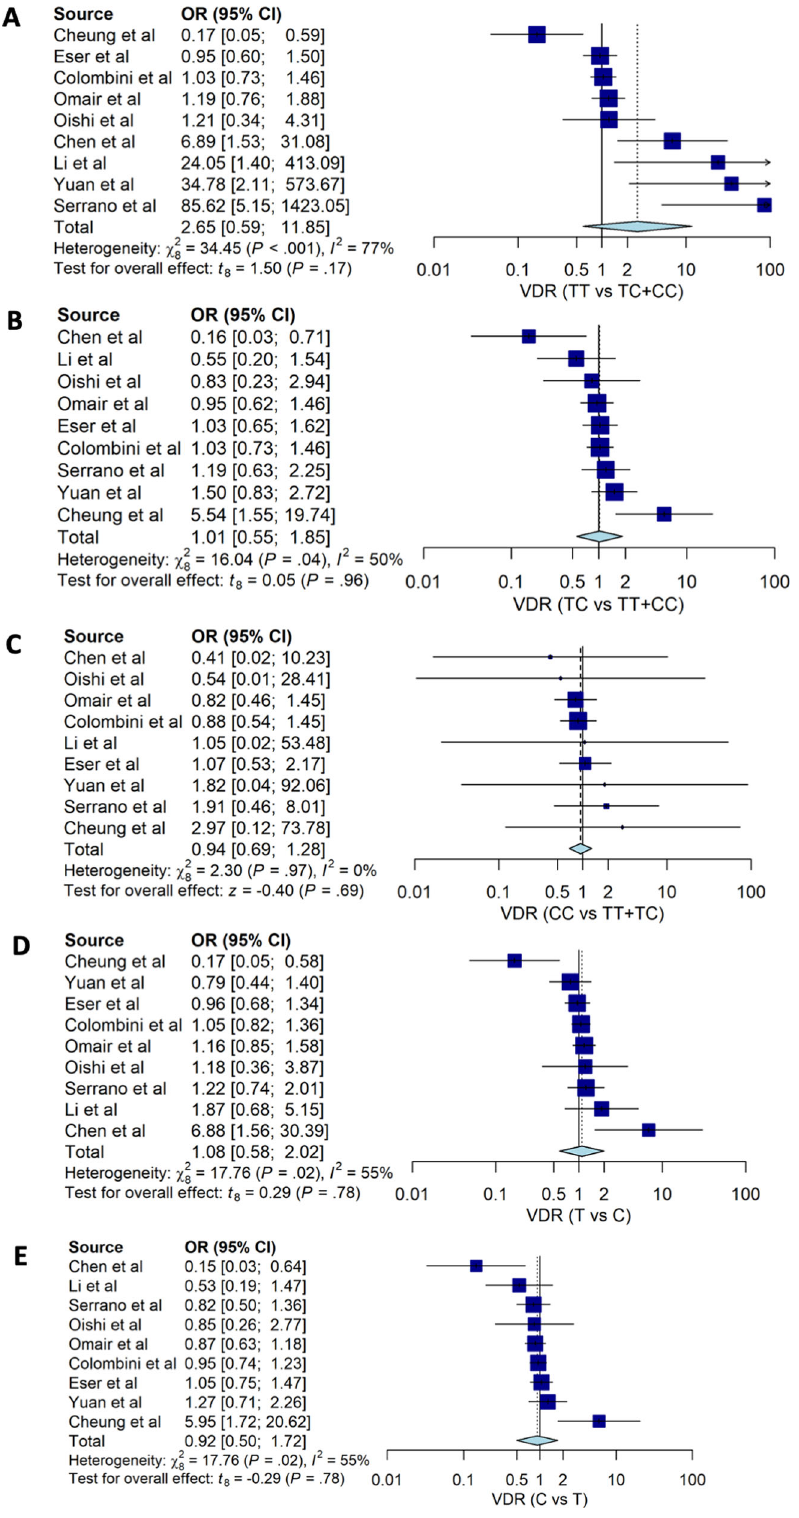
Figure4.Theforestplotoftheassociationof VDRTaqI (rs731236) andHNP. (A)TTvsTC+CC(OR:2.65;CI95%:0.60, 11.85); p-value 0.172, p-Het <0.001, p-Egger 0.986, (B) TC vs TT+CC (OR1.01; CI95%: 0.55, 1.85); p-value 0.964, p-Het 0.041, p-Egger 0.791, (C) CC vs TC+TT (OR 0.94; CI95%: 0.69, 1.28); p-value 0.688, p-Het 0.970, p-Egger 0.387, (D) T vs C (OR: 1.06; CI95%: 0.91, 1.22); p-value 0.775, p-Het 0.023, p-Egger 0.874), (E) C vs T (OR: 0.92; 95%CI: 0.50, 1.72); p-value 0.775, p-Het 0.023, p-Egger